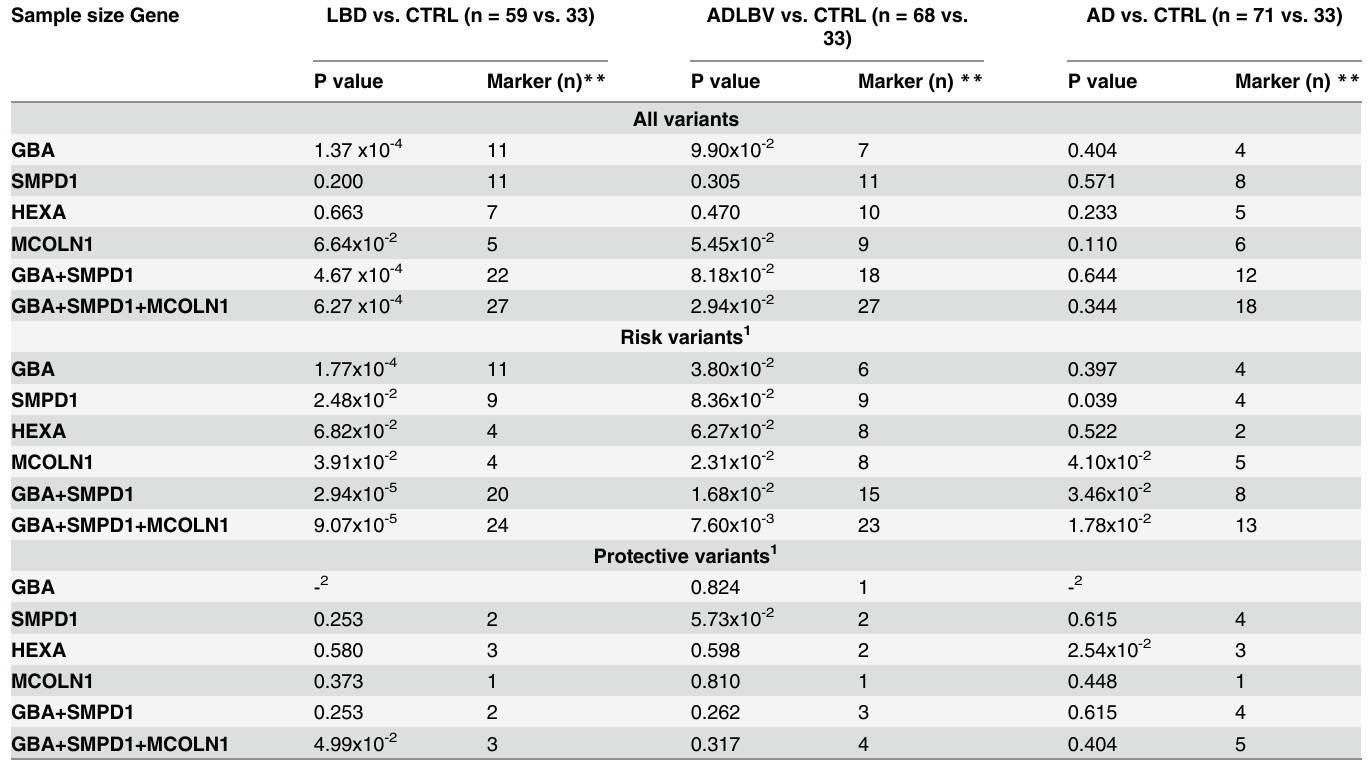
Table 4. Gene wise SKAT analysis of LSD variants with MAF < 5% in all samples. Sample size